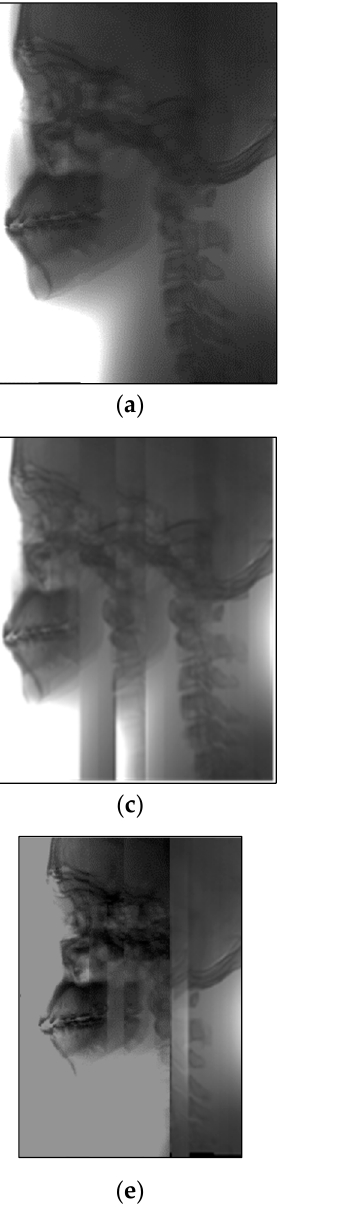
Figure 16. Sequence image stitching results by different algorithms. ( a ) This article, ( b ) SIFT-PSO, ( c ) NCC, ( d ) SIFT-NMI, ( e ) PC, ( f )